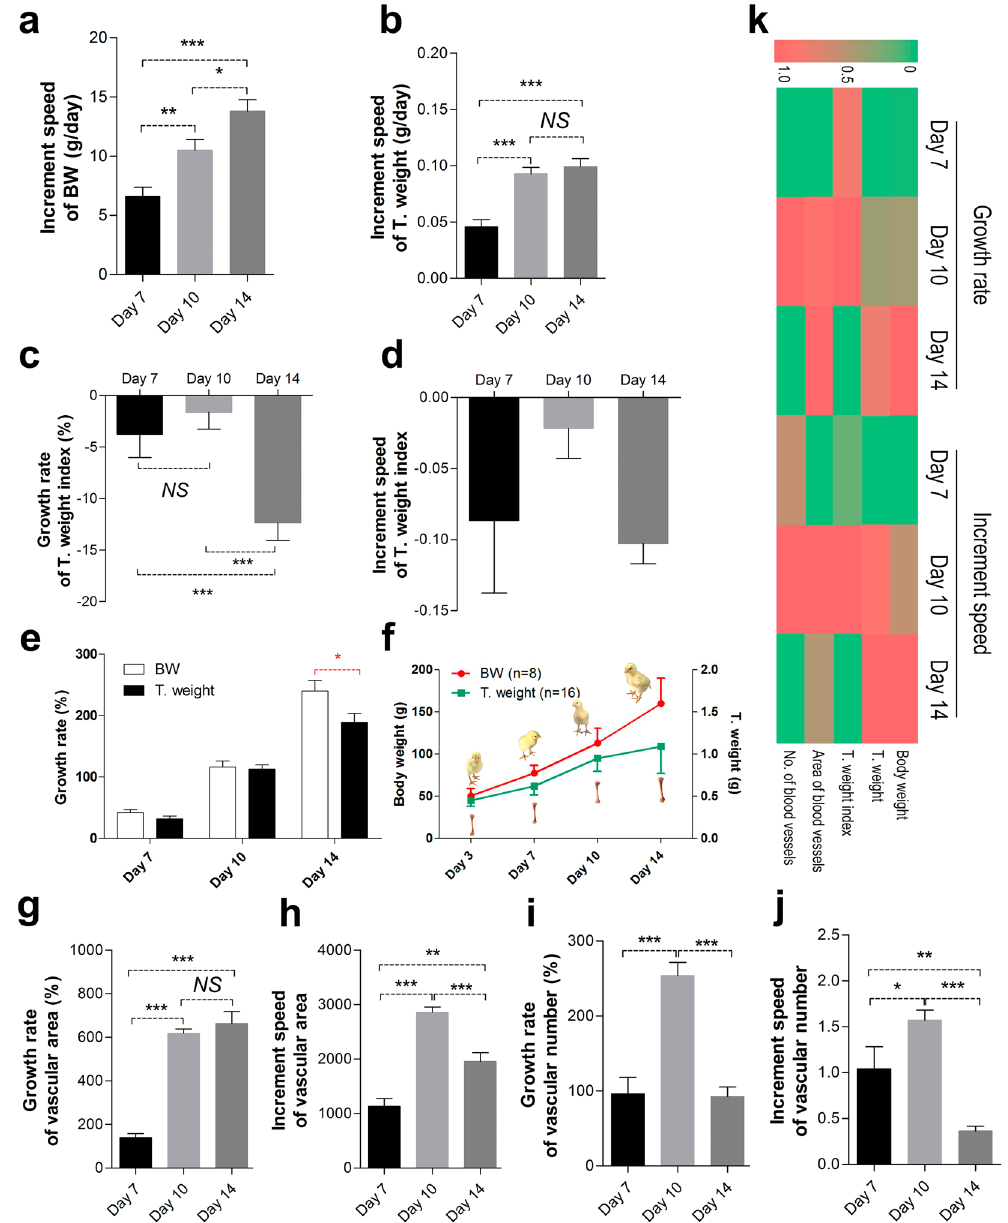
Figure 1. Growth rate of the chicken BW is not in synchronized with the growth of bones and blood vessels. ( a , b ) Quantitative analysis of increment speed of BW ( a ; body weight) and T. weight ( b ; tibia weight) in the normal group from 7-, 10 and 14-day-old broiler chickens. ( c , d ) Quantitative analysis of growth rate and increment speed of the T. weight index in the normal group from 7-, 10 and 14-day-old broiler chickens. ( e , f ) Quantitative analysis of growth rate of BW and T. weight in the normal group from 7-, 10 and 14-day- old broiler chickens. ( g – j ) Quantitative analysis of growth rate and increment speed of the vascular area and vascular number in the normal group from 7-, 10 and 14-day-old broiler chickens. N = 8 chickens in each group from four independent experiments; Data represent means ± s.d. * p < 0.05, ** p < 0.01, *** p < 0.001, one-way analysis of variance (ANOVA) and Least-significant difference (LSD) Duncan test. NS, not significant. ( k ) The changes of BW, T. weight, T. weight index, vascular area and vascular number were shown in a heatmap using the indicated pseudocolor scale from 0 percent (green) to 100 percent (red) relative to average values. Growth rate = (N t − N 0 )/N 0 * 100%; increment speed = (N t − N 0 )/(t − 0), N: value, t: end time, 0: start